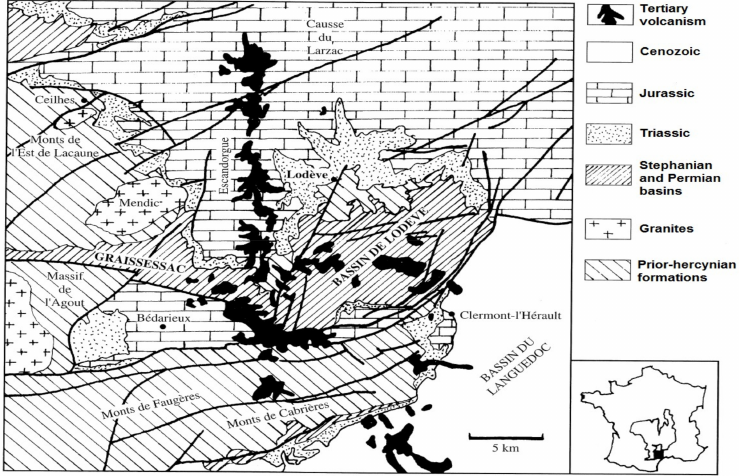
Figure 1. Geographical situation of the Permian Lod è ve basin (modified from Caubel, 1997